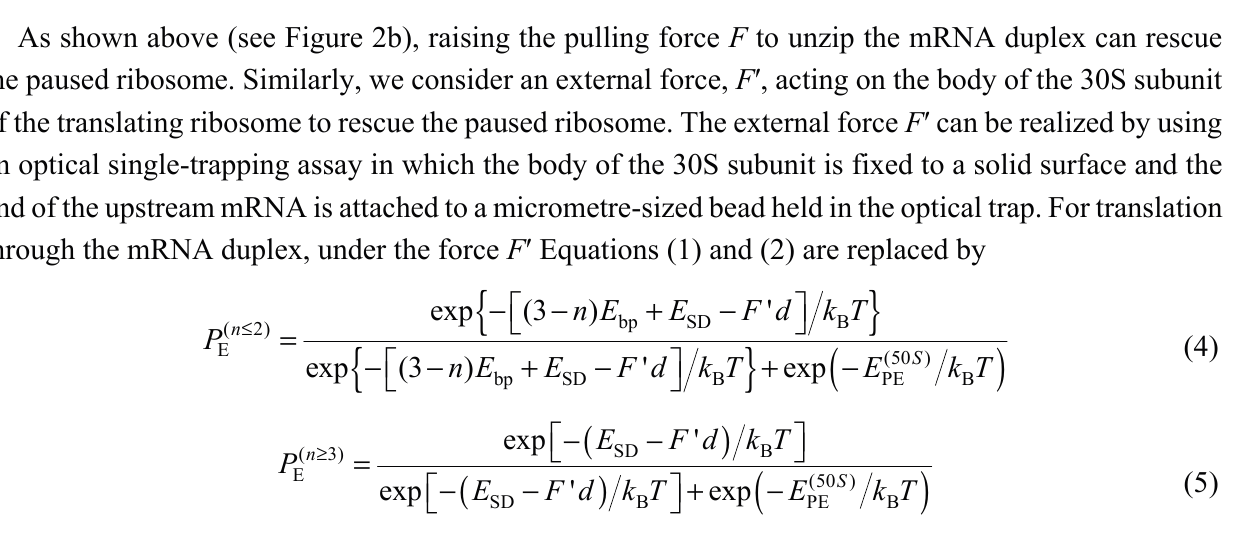
Figure 6. Dynamics of translation through the single-stranded mRNA in the presence of the interaction of the SD sequence with the anti-SD site of the 30S subunit. Probability of pausing (>10 s) vs. the binding energy between the SD and anti-SD, E SD